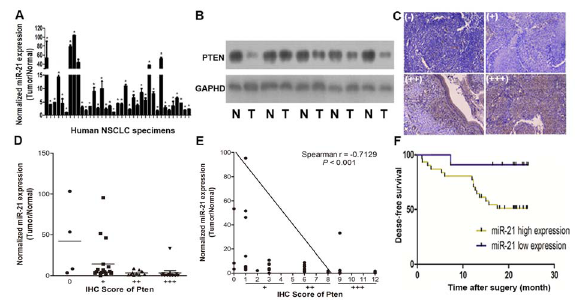
Figure 1. MiR-21/Pten expression levels in 47 pairs of NSCLC tissues and adjacent normal specimens, and relationship with disease free survival. (A) Expression levels of miR-21 were up- regulated in 37/47 pairs of NSCLC tissues relatively to adjacent normal specimens. MiR-21 were analyzed by stem-loop qRT-PCR, and normalized to the levels of U6. Fold changes were obtained by the ratio of miR-21 abundance in cancer tissues to that in adjacent normal tissues. * p , 0.05 indicates significant difference comparing miR-21 expression in tumor tissues with adjacent normal tissues. (B) Representative Pten protein levels in NSCLC tissues (T) and adjacent normal specimens (N) assessed by immunoblot, GAPDH was used as loading control. (C) Pten Immunohistochemistry (IHC) results of NSCLC sections, 0 (negative), + (weakly positive), ++ (moderately positive), and +++ (strongly positive). (D) Correlation analysis between Pten protein levels and miR-21 expression levels in NSCLC tissues. IHC scores were used to describe Pten protein levels in tumor tissues, evaluated by experienced pathologists in a blinded manner. (E) Linear regression curves of miR-21 expression and Pten protein levels. (F) Kaplan-Meier curves depicting Disease-free survival according to expression of miR-21. The cutoff value of the subgroups (high and low) of miR-21 expression level was the 50th percentile value. doi:10.1371/journal.pone.0103305.g001 ranged from ( ++ ) to ( +++ ) (Fig. 2B). To further confirm our findings, we assessed miR-21 expression levels using ISH assays (Fig. 2D) and Pten expression levels by IHC on paraffin embedded samples from 46 NSCLC patients treated with TKI(gefitinib or erlotinib) as treatment and followed up their clinical response and survival status (Table S2). As expected, miR-21 expression levels in PD patients were significantly higher than those in PR and SD groups(Fig. 2C). Higher miR-21 expression levels also indicated shorter overall survival in TKI treated patients (Fig. 2E). In addition, Pten expression levels in PD patients was significantly lower than in PR and SD patient groups (Fig. 2F), and higher Pten expression correlated with longer overall survival in TKI treated patients (Fig. 2G). These findings are all in agreement and suggest involvement of high miR-21/low Pten expression in modulation of TKI sensitivity in NSCLC.